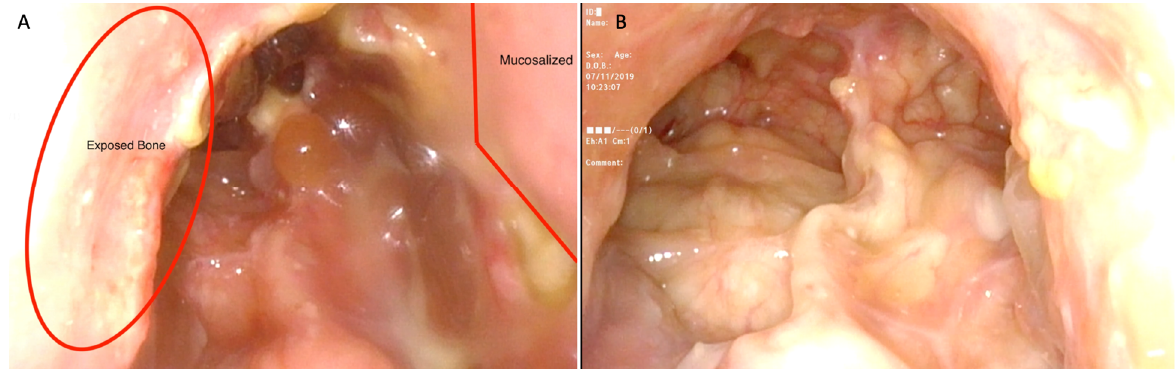
Figure 2. Endoscopic post-EMLP view of frontal neo-ostium. ( A ) Four weeks post-EMLP with left-sided anteriorly-based lateral nasal wall flap. On the right, exposed bone is demonstrated. ( B ) Six weeks post-EMLP frontal neo-ostium demonstrating common drainage pathway for left and right frontal sinus.